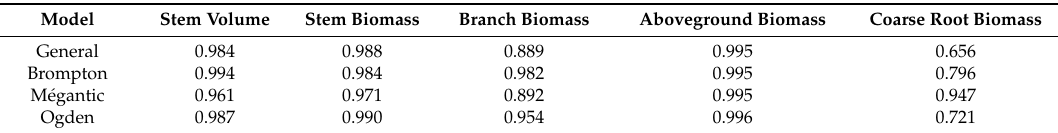
Table 6. Mean values of cross-validated R 2 (fivefold cross-validation repeated 5 times) for the general and site-specific allometric models developed for the different tree